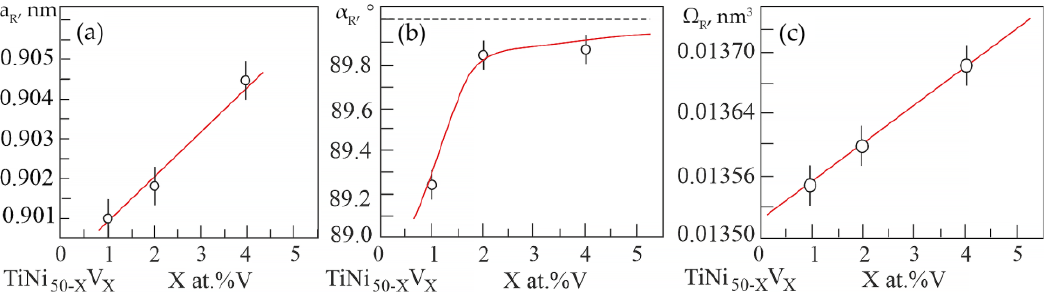
Figure 5. Concentration dependences: ( a ) — lattice parameter; ( b ) — rhombohedricity angle; ( c ) — atomic volume in the R-phase of alloys based on TiNi doped with V.